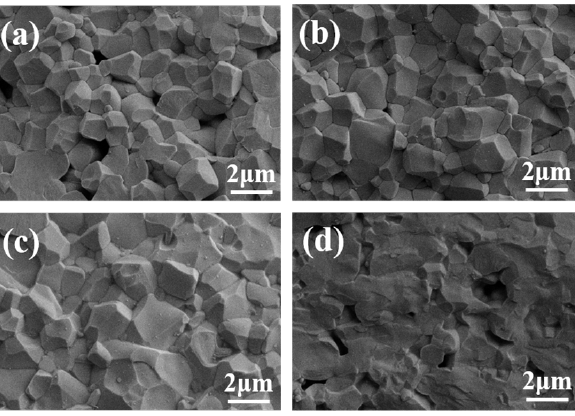
Figure 2: Microstructures of PNN-PZT-xCuO-yLiBiO 2 ceramics. (a) x = 0.1, y = 1; (b) x = 0.1, y = 2; (c) x = 0.2, y = 1; (d) x = 0.2, y = 2.